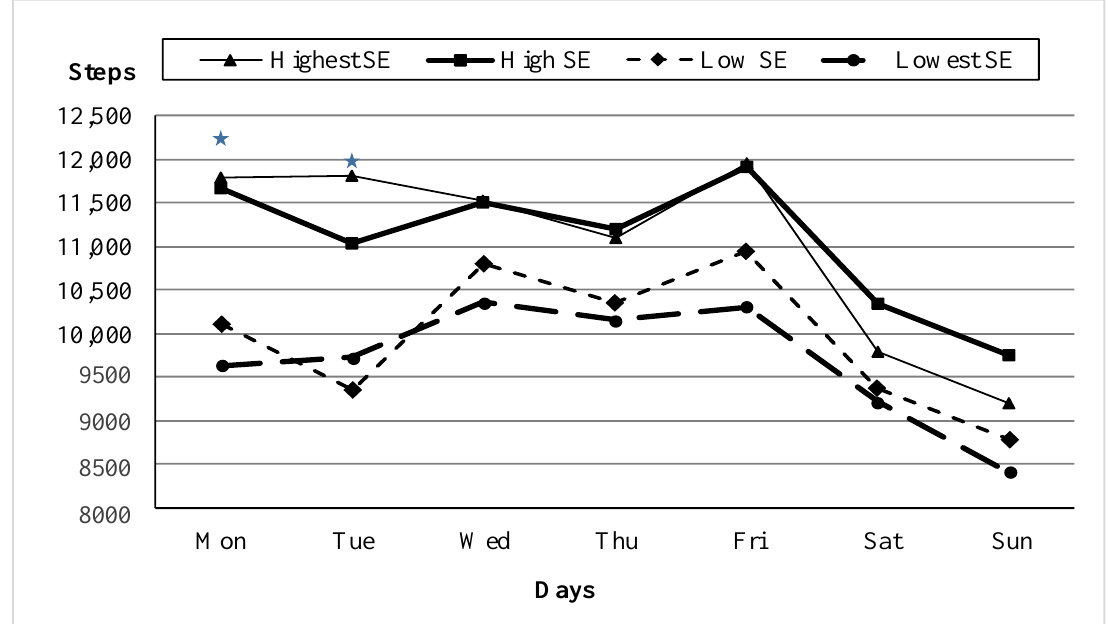
Figure 2. Adolescents’ average daily step count for each day of the week ( n = 550) according to environmental safety (ES) (* = p < 0.05).